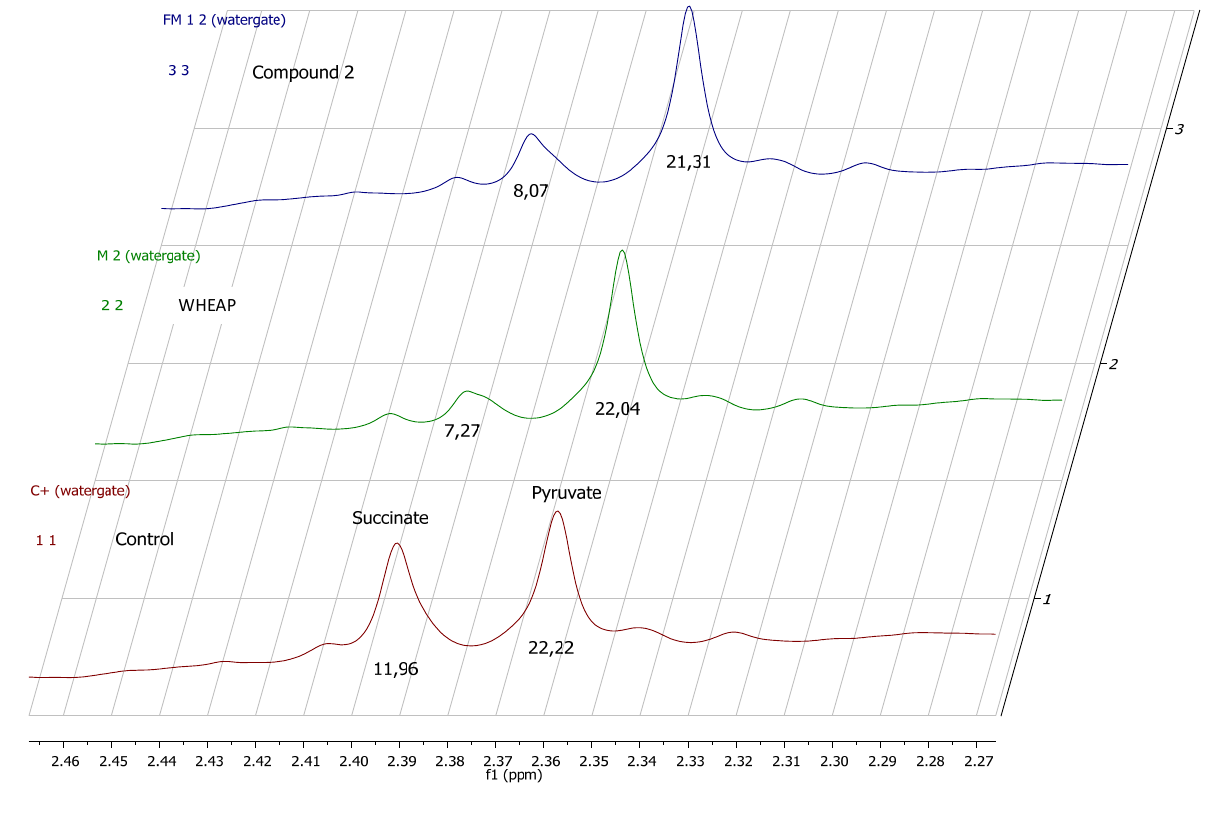
Figure 5. Stacked 1 H-NMR spectra in the Succ and Pyr zone. A decrease in the Succ signal was clearly observed when the parasites were incubated with WHEAP or with compound 2